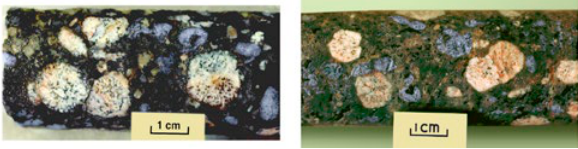
Figure 71. Syneresis shrinkage crack patterns from the precursor clay accretions are preserved in the feldspars of the Great Western por- phyroid at Tennant Creek. Figure 69. Syneresis shrinkage patterns in Tennant Creek coarse porphyroids have associated orebodies.